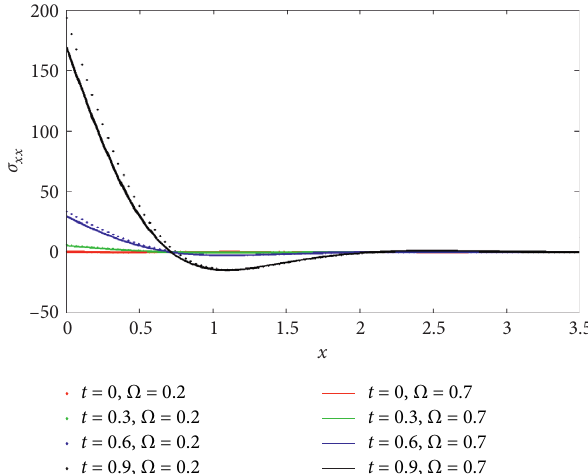
Figure 17: Temperature T concerning x under gravity and rotation.